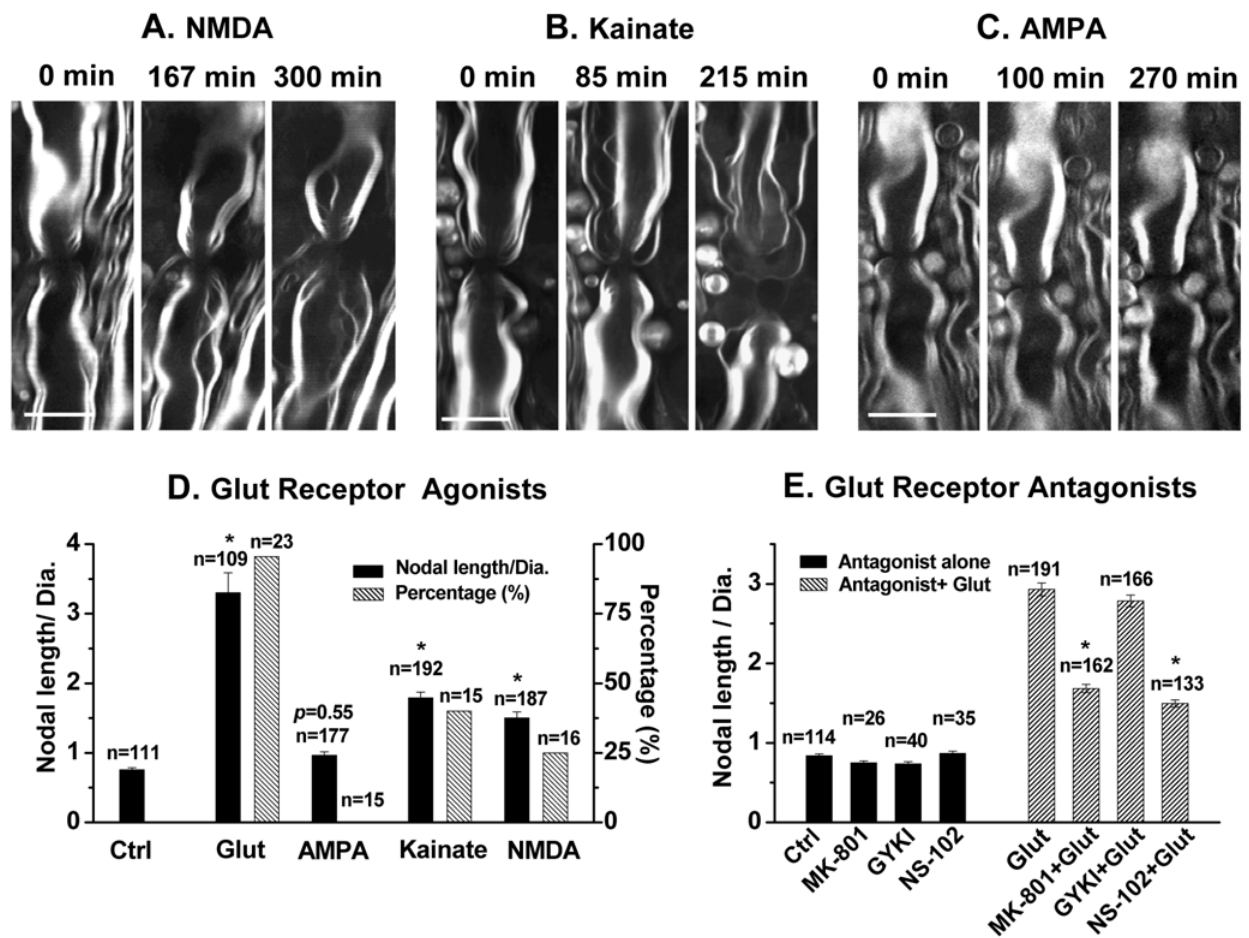
Figure 5. Glutamate excitotoxicity in paranodal myelin is mediated by kainate and NMDA receptors. (A) CARS images of paranodal myelin under NMDA (0.68 mM plus 27 m M glycine) treatment at different time periods. 27 m M glycine was used to maximize activation of NMDA receptors. (B) CARS images of paranodal myelin under kainate (1 mM) treatment at different time periods. (C) CARS images of paranodal myelin under AMPA (0.16 mM) treatment at different time periods. (D) NMDA, kainate, but not AMPA induced paranodal myelin retraction. Black bars represent the average ratios of nodal length to diameter under various treatments. White bars with patterns represent the percentages of paranodal myelin damage under various treatments. * p , 0.001 compared with the control. (E) Glutamate-induced paranodal myelin retraction is partially diminished by antagonists of NMDA, kainate, but not AMPA receptor. MK-801 (a noncompetitive NMDA antagonist), GYKI52466 (a selective AMPA antagonist) or NS-102 (a selective kainate antagonist) were used. The spinal tissues were pre-incubated in the Krebs’ solution supplemented with a specific glutamate receptor antagonist at 37 u C for 0.5 h. Glutamate (1 mM) was then added into the incubating solution. After additional 1 h incubation, the nodal lengths and nodal diameters in the spinal tissue were measured by CARS. * p , 0.001 compared with the ‘Glut’ group. Bar=10 m m in (A–C).